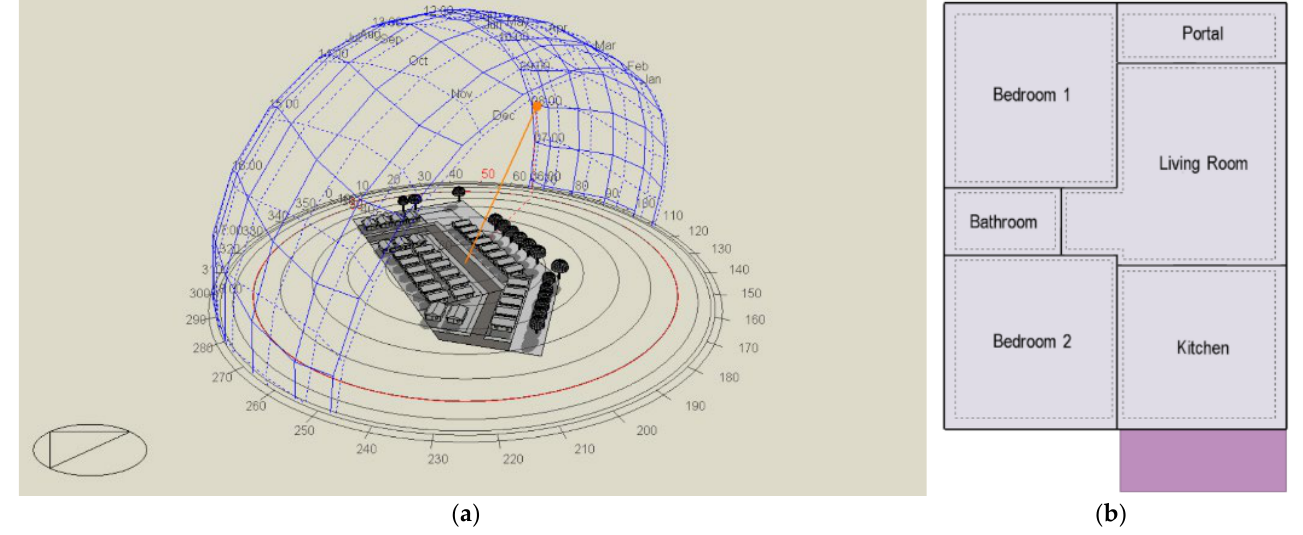
Figure 2. Case study: ( a ) 3D urbanization model, and ( b ) plan view with the layout of each room within the houses.